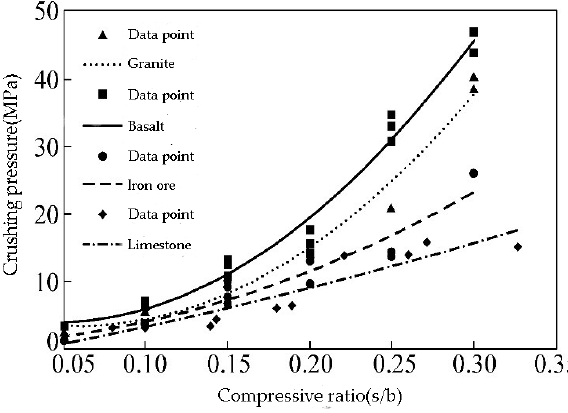
Figure 3. Relationship between pressure of single factor multi-material crushing and compressive ratio.